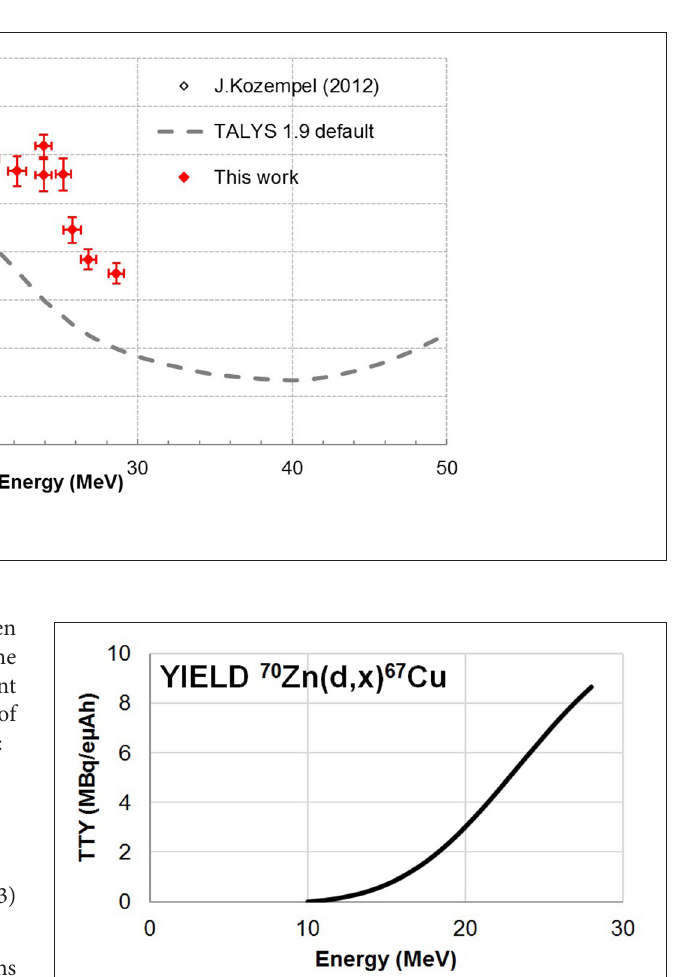
FIGURE 2 | Thick Target Yield curve for the 70 Zn(d,x) 67 Cu reaction